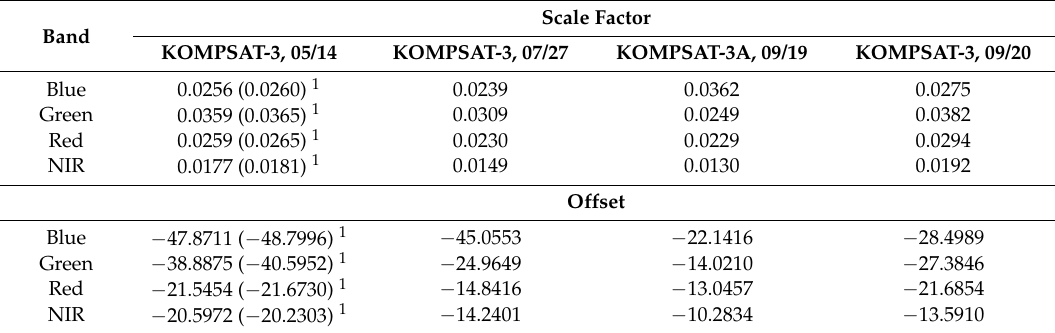
Table 4. Updated DN to radiance coefficients and offsets for KOMPSAT-3 and -3A based on